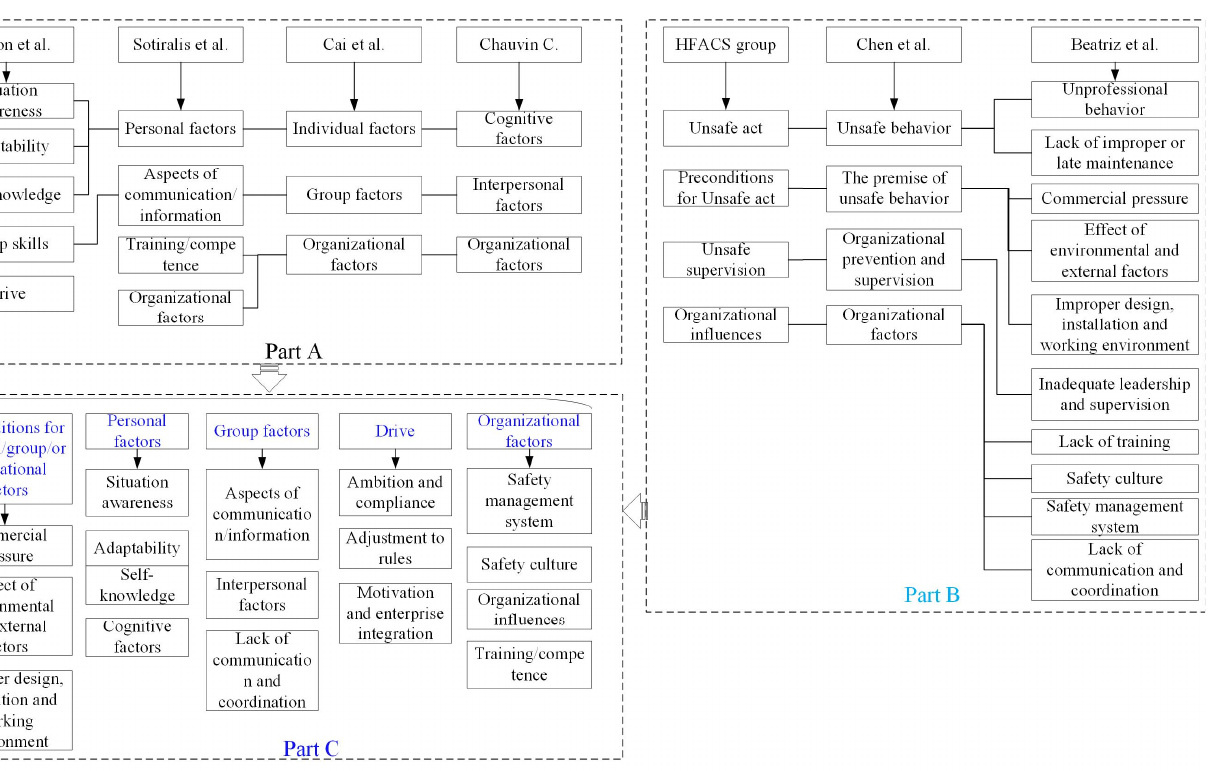
Figure 4. Summary of “human factor”.